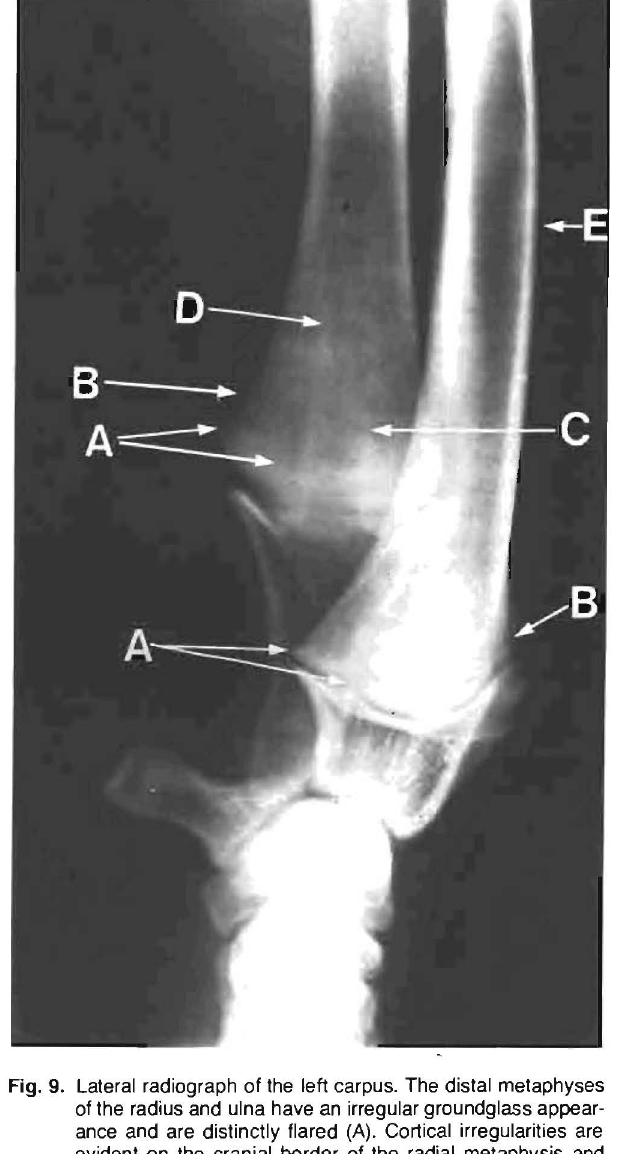
Fig. 8. Oorsopalmar radiograph of the left and right (R) carpal joints. In both forelegs the distal metaphyses of the radius and ulna are slightly flared and have an irregular groundglass appear· ance (A). Irregularity of the cortex is present in the medial as· pect of the distal radial metaphyses (8). A radiolucent band extends across each of the distal ulnar metaphyses (C). A retained enchondral cartilage core is evident in both of the distal ulnar metaphyses and extends into the diaphyses (0).